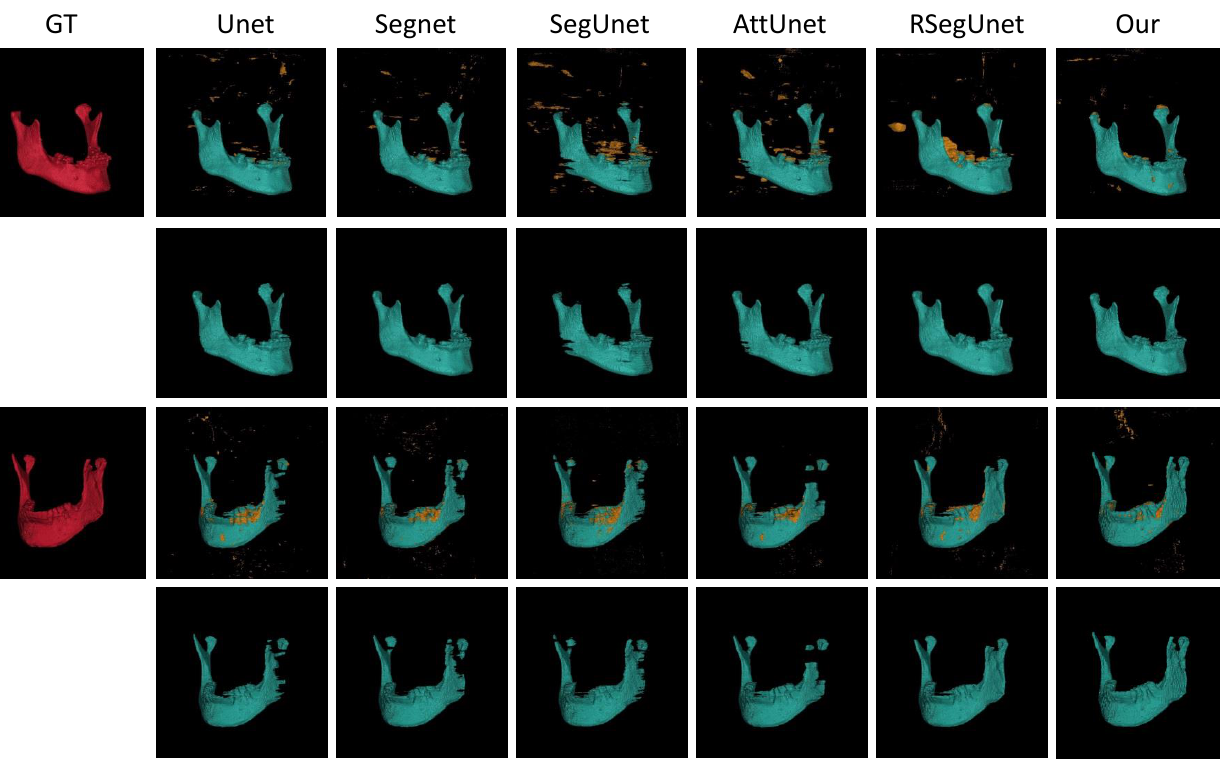
Figure 5. Visual 3D examples of final segmentations from the CBCT dataset. From left to right: Ground truth (GT), Unet, Segnet, SegUnet, AttUnet, RSegUnet, and the proposed method.